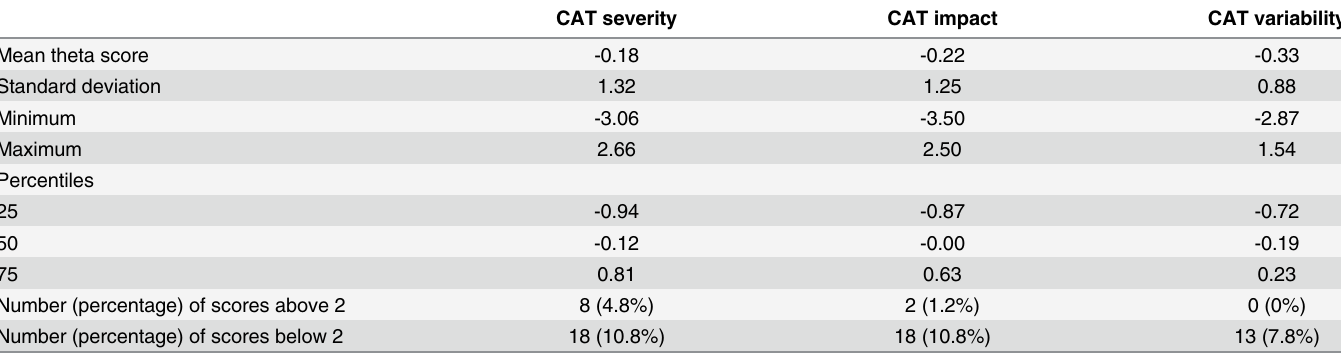
Table 2. Theta-scores per CAT dimension.